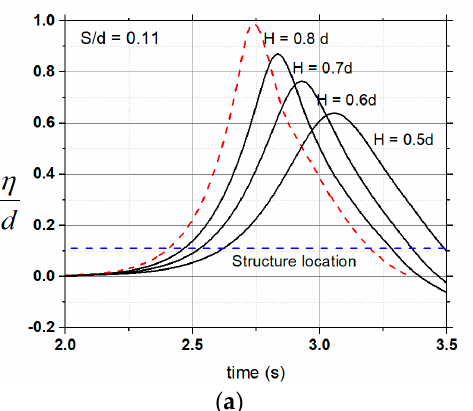
Figure 9. Peak impact force for the increasing wave height for different airgaps at a constant depth, d = 0.35 m. ( a ) Vertical impact force ( b ) Horizontal impact force.